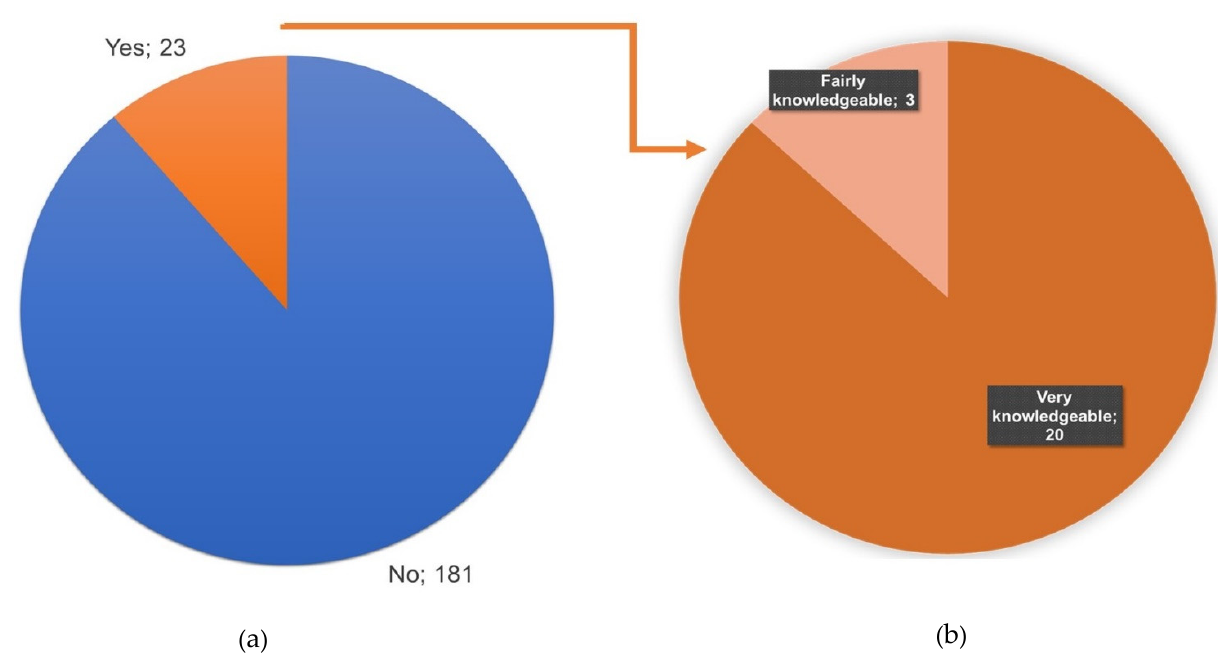
Figure 12. A presentation of whether the interviewees know about flood adaptation ( a ), and how knowledgeable they are ( b ). Source: Fieldwork.